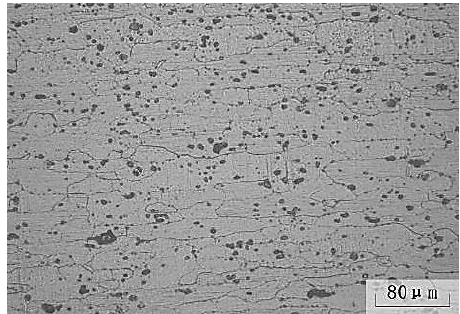
Figure 1. Microstructure of aluminum (Al) alloy BM.